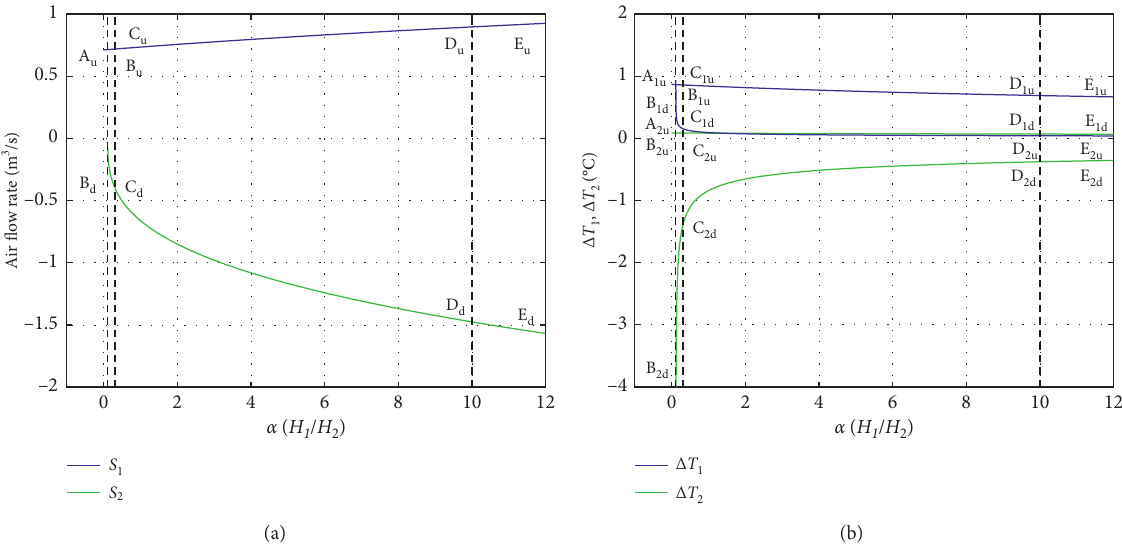
Figure 9: Bifurcation diagram. (a) Air flow rate. (b)